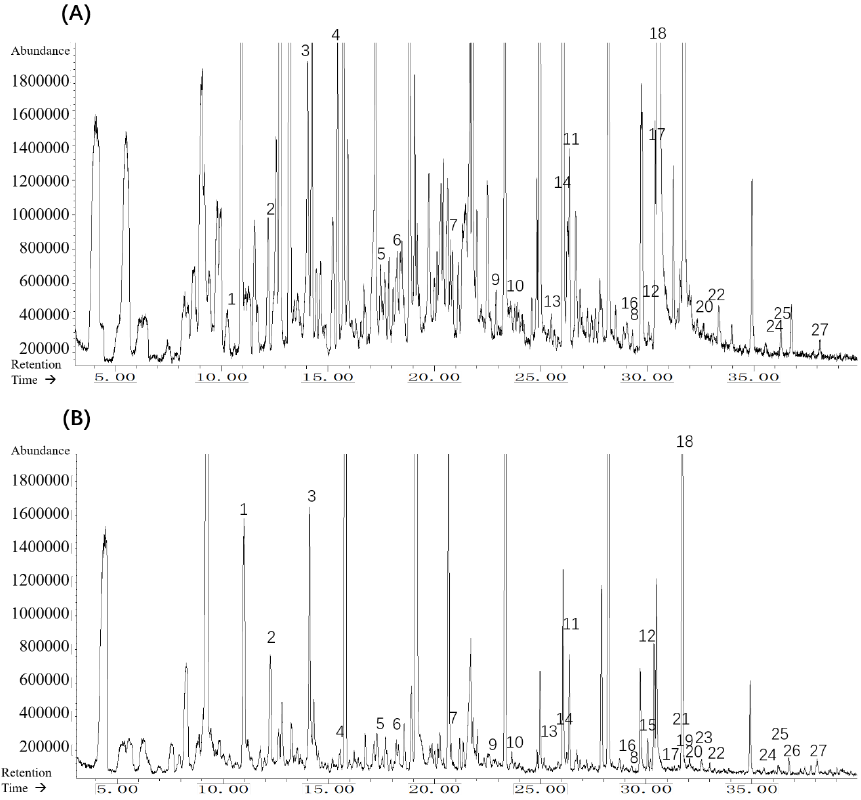
Figure 2. Gas chromatography–mass spectrometry (GC–MS) chromatograms showing the identified terpenes in ( A ) vintage 2016 and ( B ) vintage 2017. Peaks: (1) cymene(m- and p-); (2) γ-terpinene; (3)